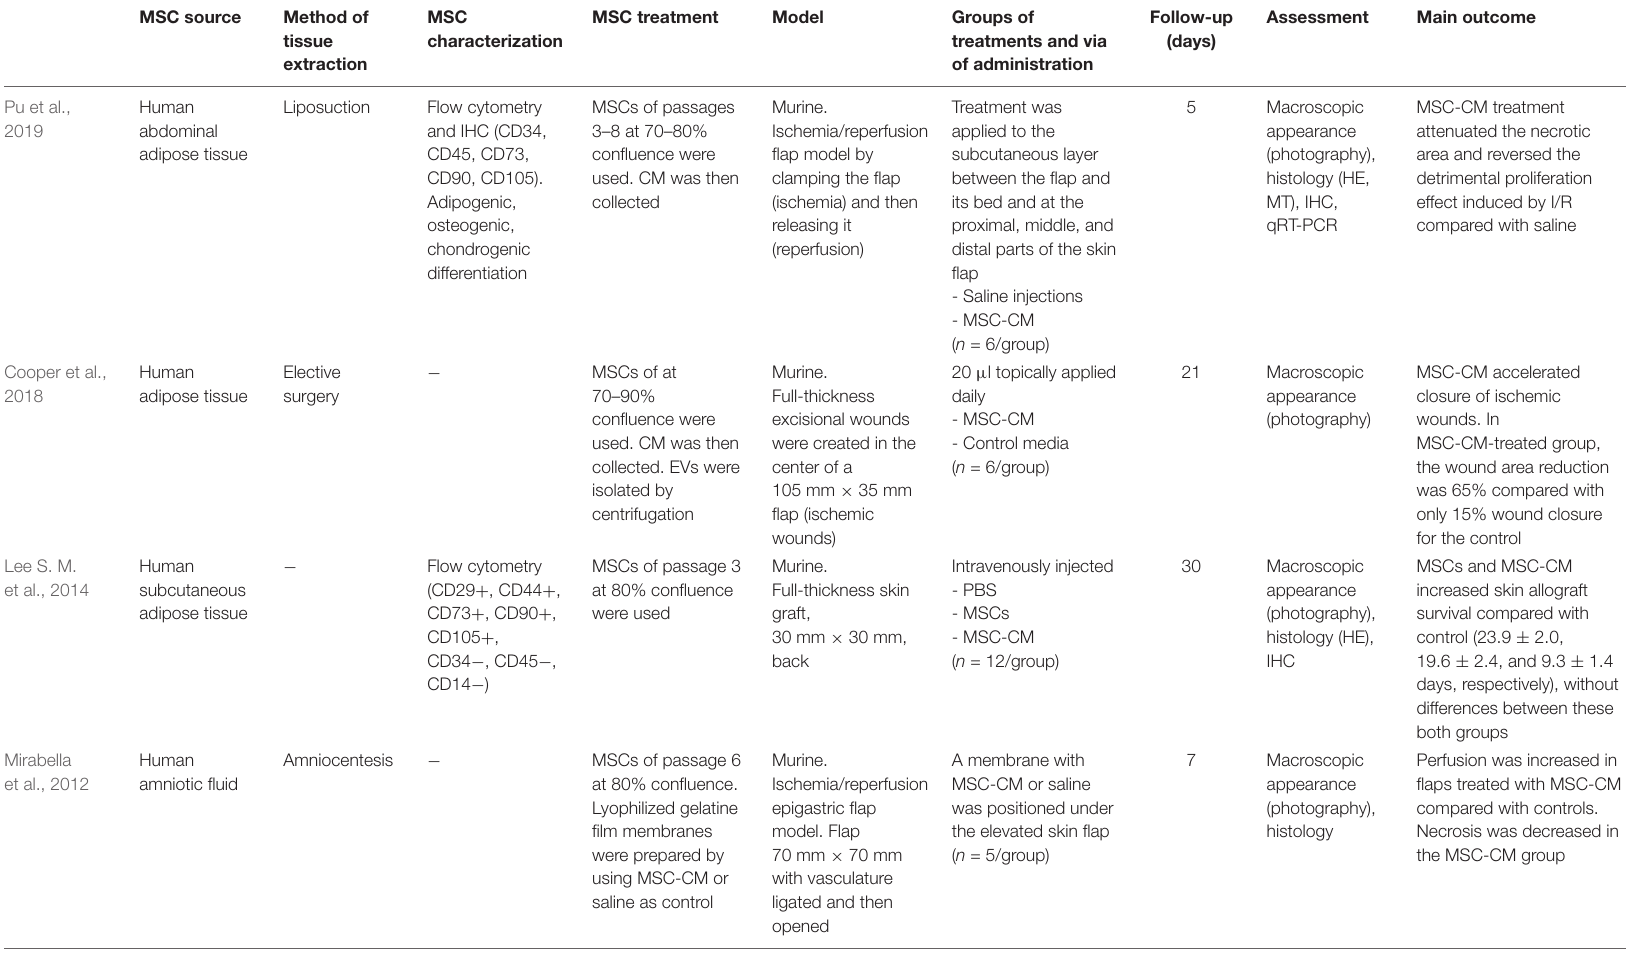
TABLE 6 | Studies regarding mesenchymal stromal cell-conditioned medium for improving flaps reperfusion in animal